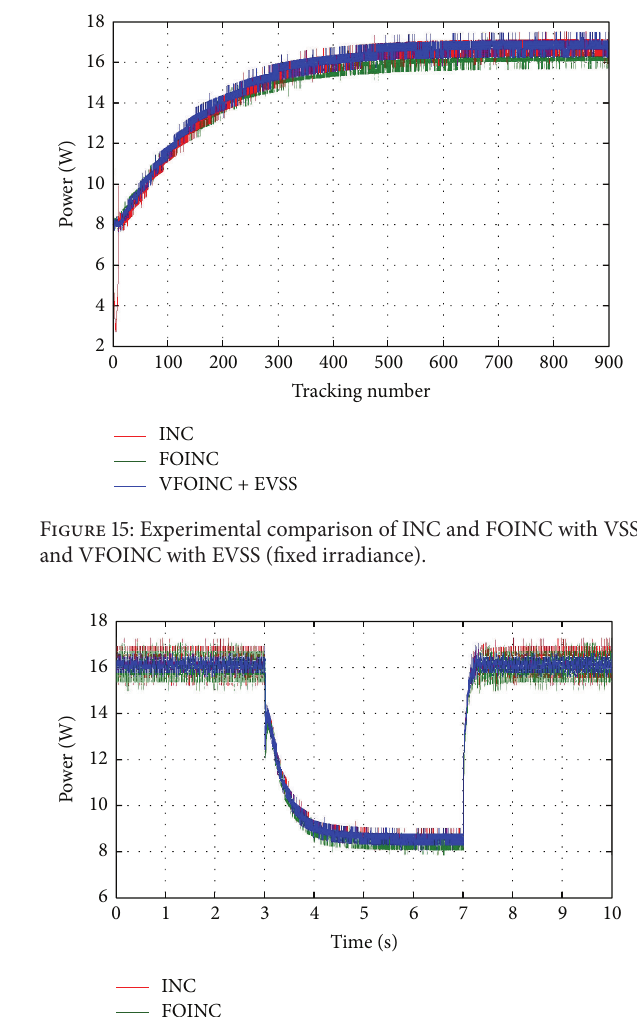
Figure13:ComparisonofINCandFOINCandVFOINCwithEVSS (variable irradiance).